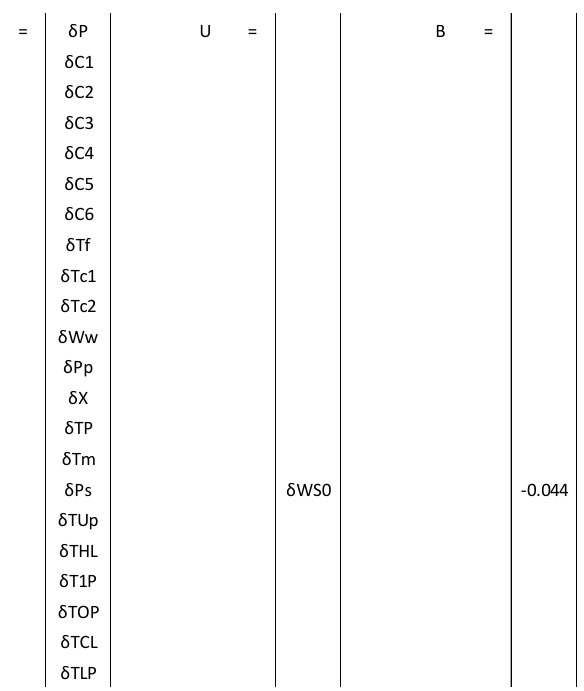
Figure 10. State-space system using Simulink.